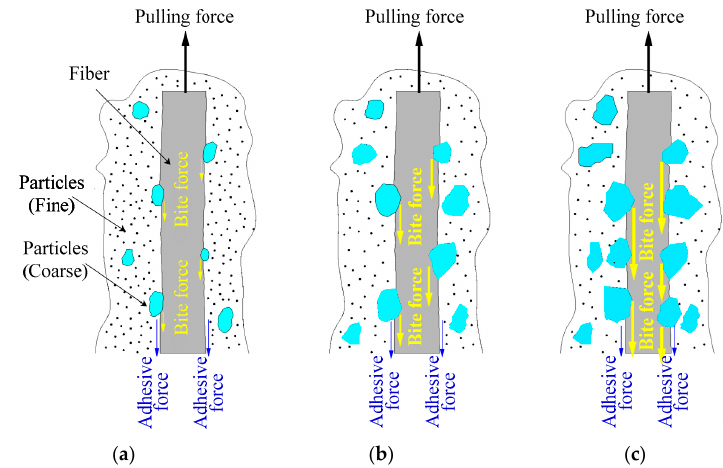
Figure 19. Sketch of interfacial mechanics behaviors between tailings particles and fibers. ( a ) Tailings clay , ( b ) tailings silt , ( c ) tailings sand. clay, ( b ) tailings silt, ( c ) tailings